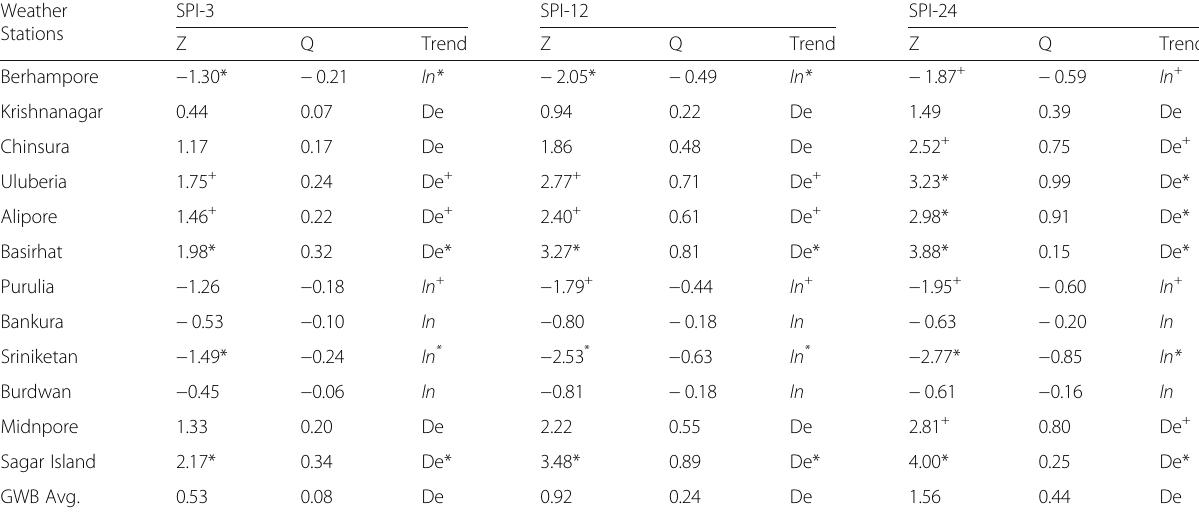
Table 8 Result of MK (MMK) test, Sen ’ s slope and % change over 1901 – 2002 in different drought series Weather Stations